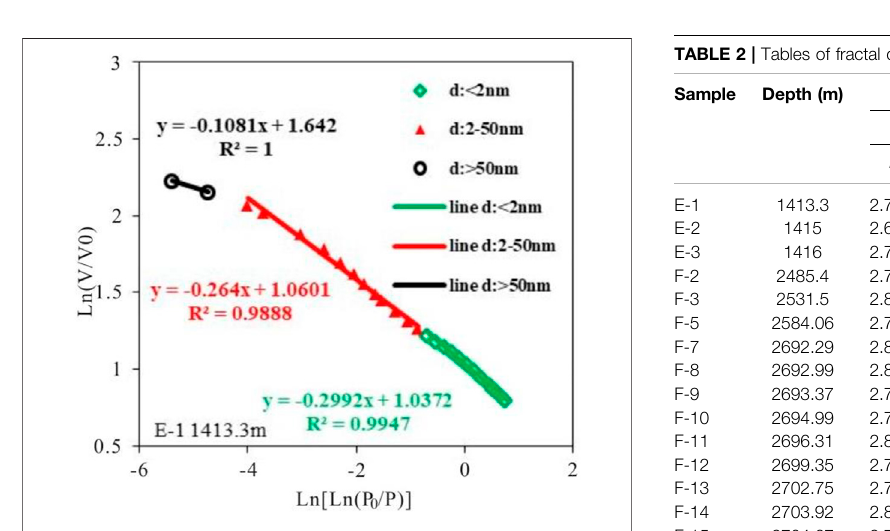
FIGURE 13 | Fractal dimensions of the pores in Shanxi Formation shale samples.